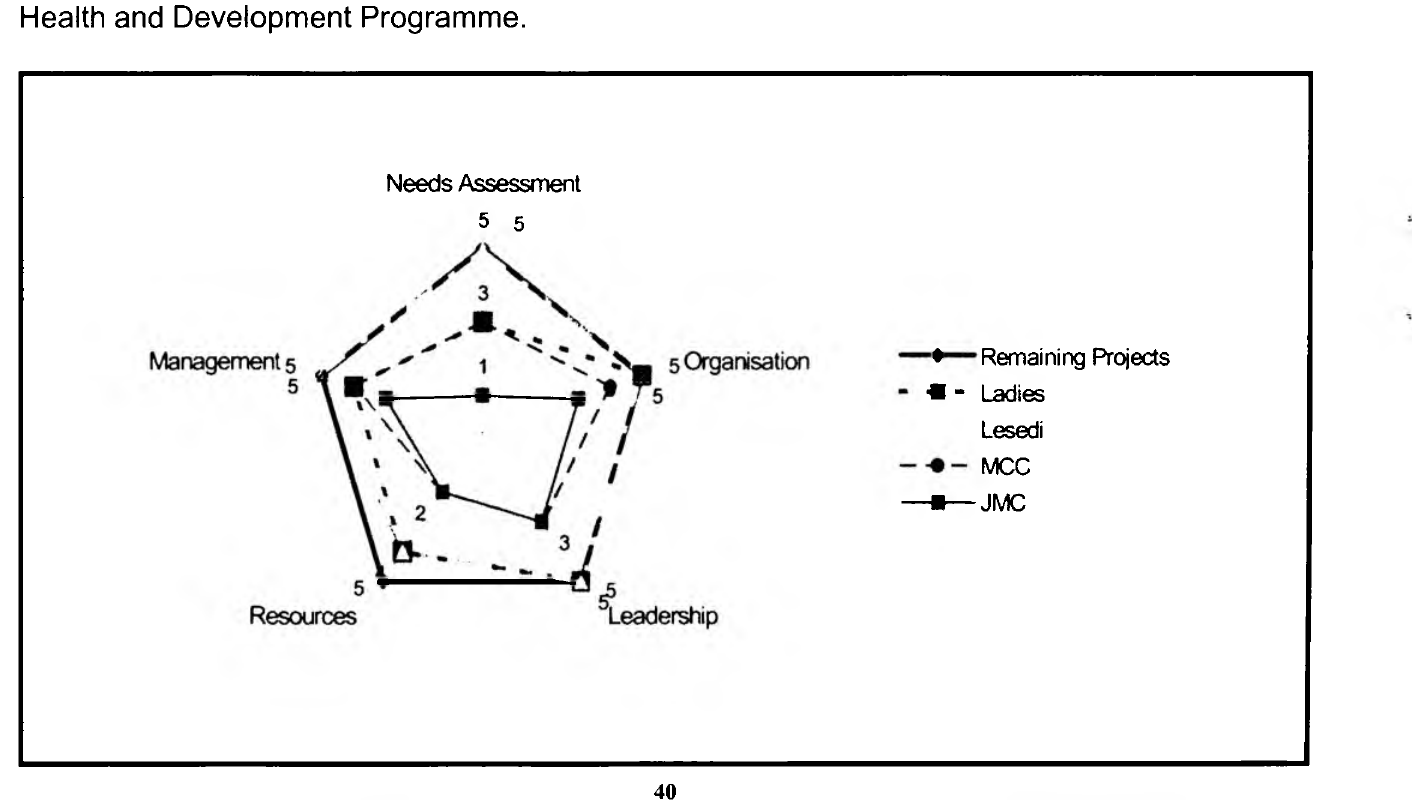
Figure 1 Comparative levels of community participation achieved by the PHC projects of the Muldersdrift Health and Development